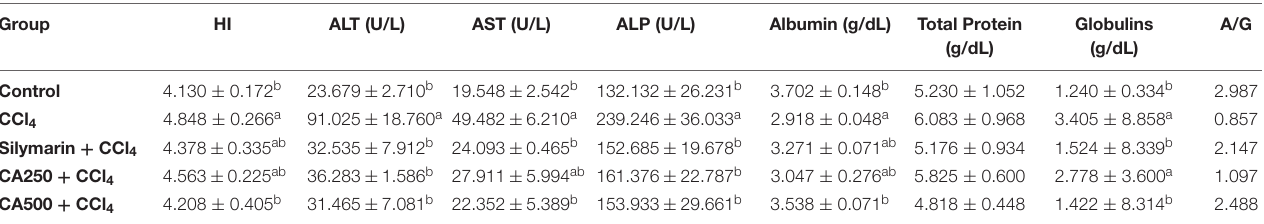
FIGURE 1 | Base peak chromatogram of the Egyptian cultivar ‘Giza 1’ showing the characterized phenolic compounds peaks numbers. TABLE 1 | Hepatoprotective effect of reference drug silymarin, chickpea extract (CA250 and CA500) against carbon tetrachloride (CCl 4 ) induced hepatotoxicity on hepatic index and serum levels of aminotransferase (ALT), aminotransferase (AST), and alkaline phosphatase (ALP), albumin, total protein, and globulins, and A/G